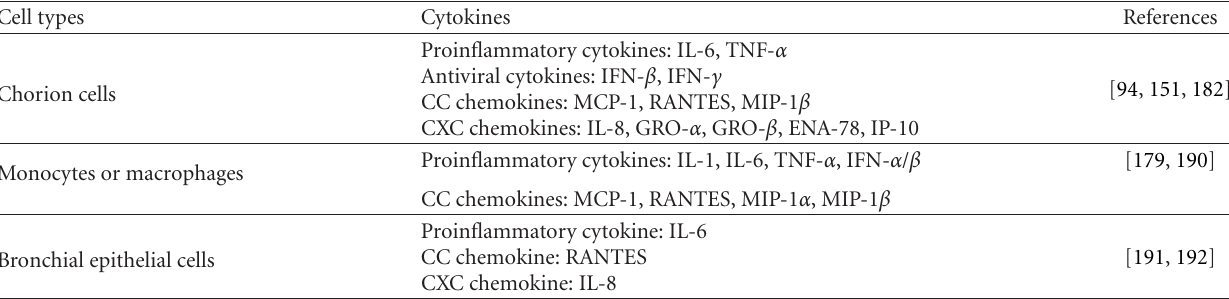
Table 6: Cytokines induced by influenza A virus infection in host cells undergoing